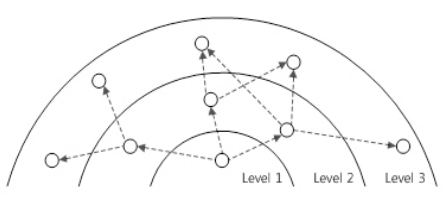
Fig. 1. Broadcast for tree construction in a